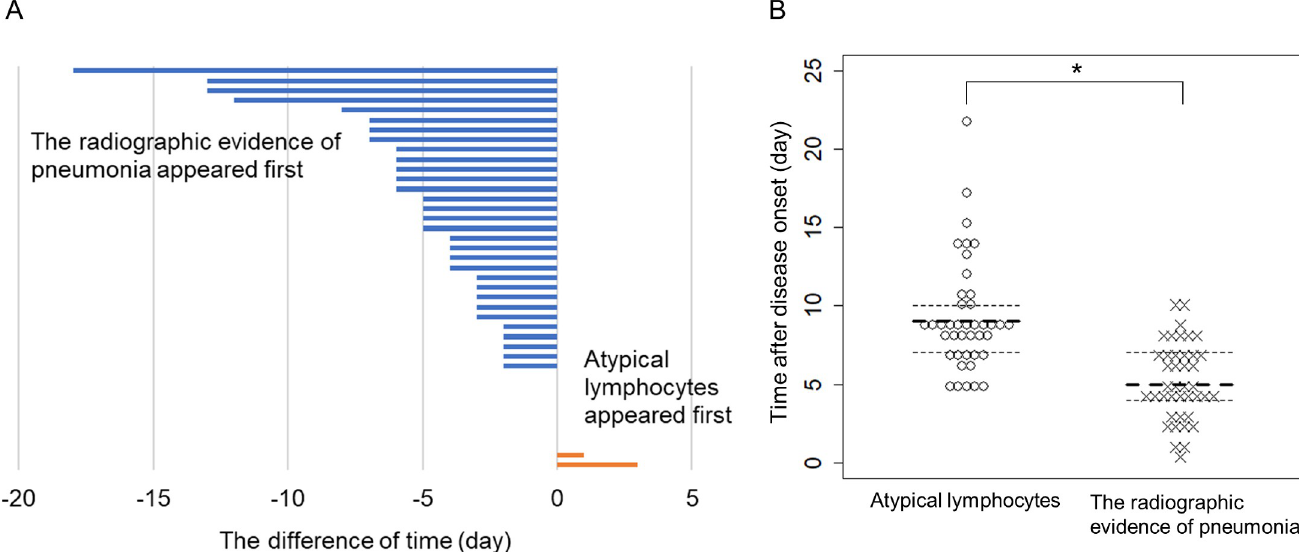
Fig 4. Comparison of dates on which pneumonia and atypical lymphocytes appeared. (A) Difference between the days on which radiographic evidence of pneumonia and atypical lymphocytes were detected in each patient. Total number of patients was 41. Bars represent the difference for each patient in days and are arranged in ascending order. A negative value (blue bar) indicates that the radiographic evidence of pneumonia appeared first, and a positive value (orange bar) indicates that atypical lymphocytes appeared first. (B) Beeswarm plot of the first day of detection. The bold dotted line indicates the median, and the thin dotted lines indicate the upper and lower quantiles. � p < 0.0001 by Wilcoxon rank-sum test.